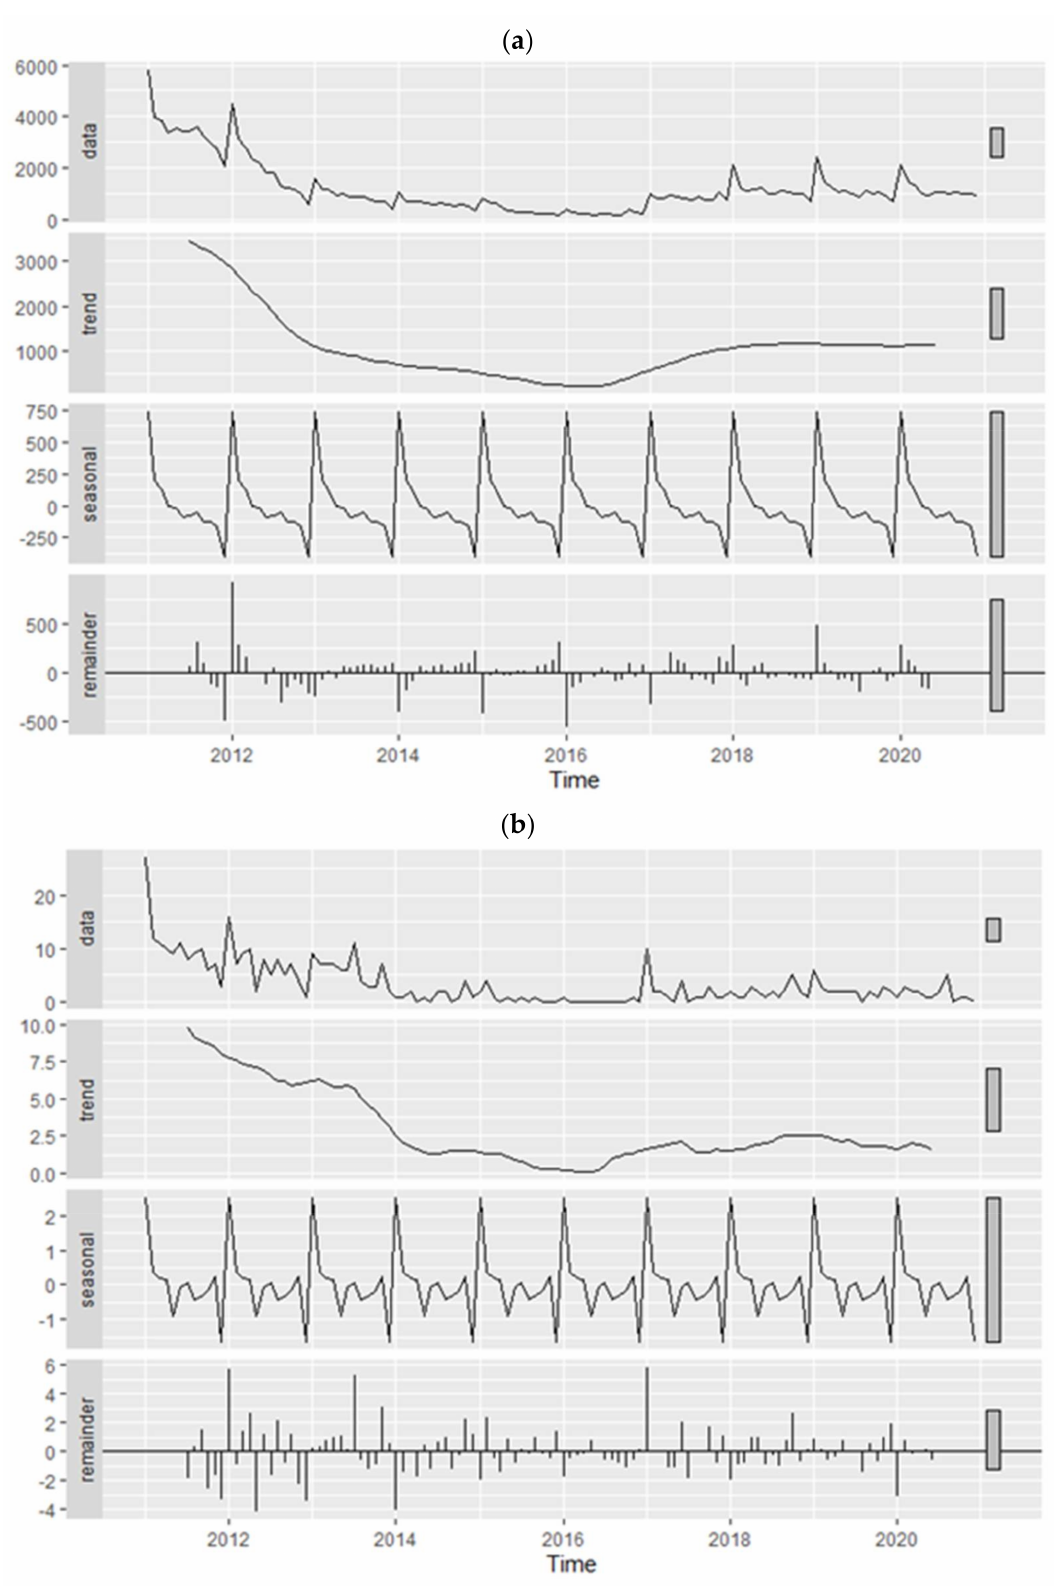
Figure 3. Time series decomposition of the monthly notified TB incidence ( a ) and mortality ( b )